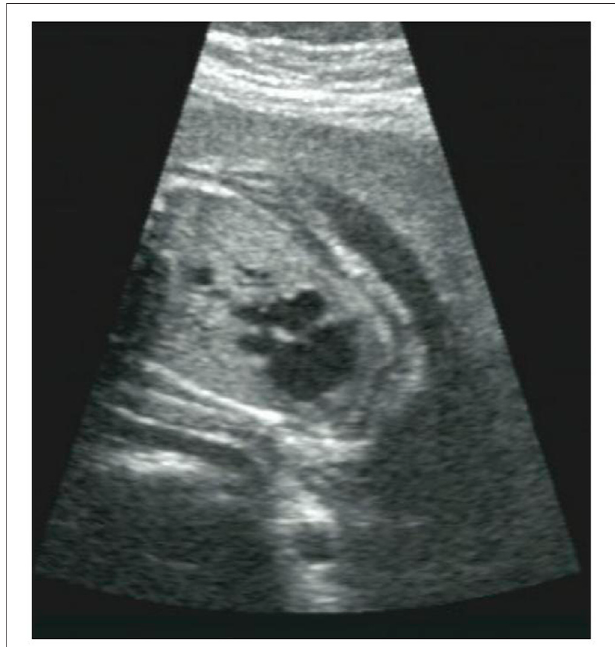
FIGURE1| Thefetuswithcongenitalheartdisease.Ultrasoundscansof the fetus showed abnormal heart development, a single ventricle, pulmonary artery stenosis and situs